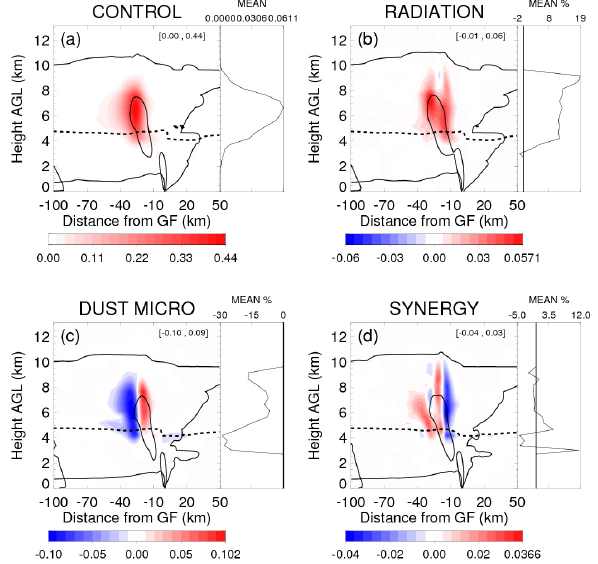
Fig. 13. Same as Fig. 10, except for the riming rate of cloud water onto hail (g kg − 1 5min − 1 ) .